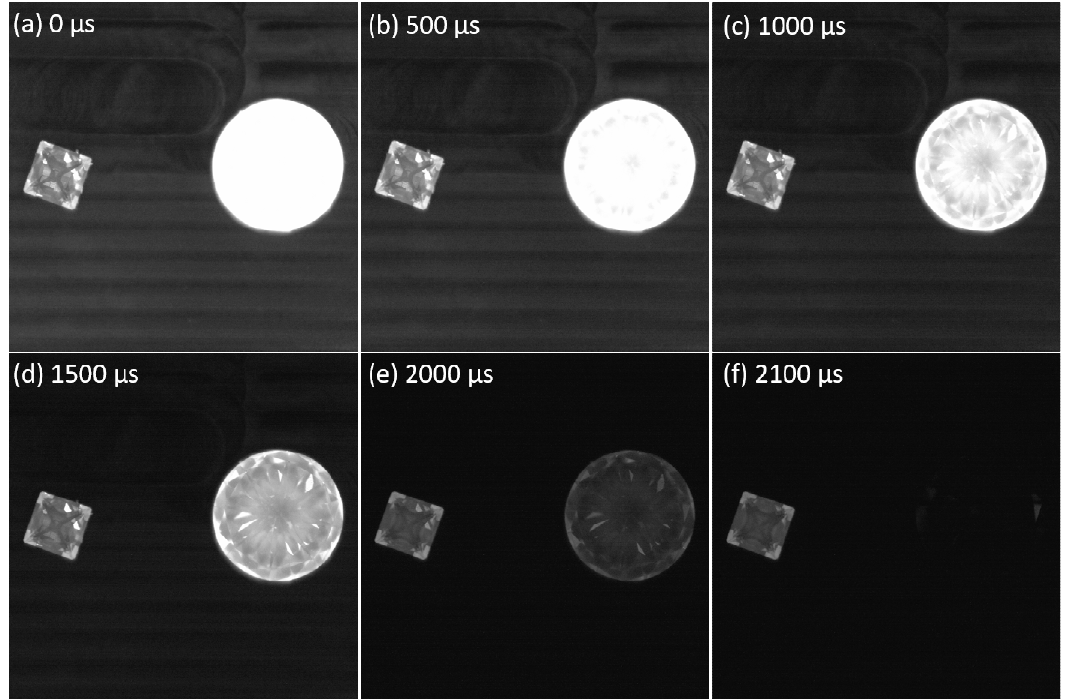
Figure 7. Real-time image capture of same round brilliant diamond (1 ct), as shown in Figure 6 and square-shaped CZ (Princess-cut) of 2.75 mm, as shown in Figure 4a, with increasing exposure delay ( μ s) ( a – f ), 2 ms exposure and 2 ms LED excitation pulse used.